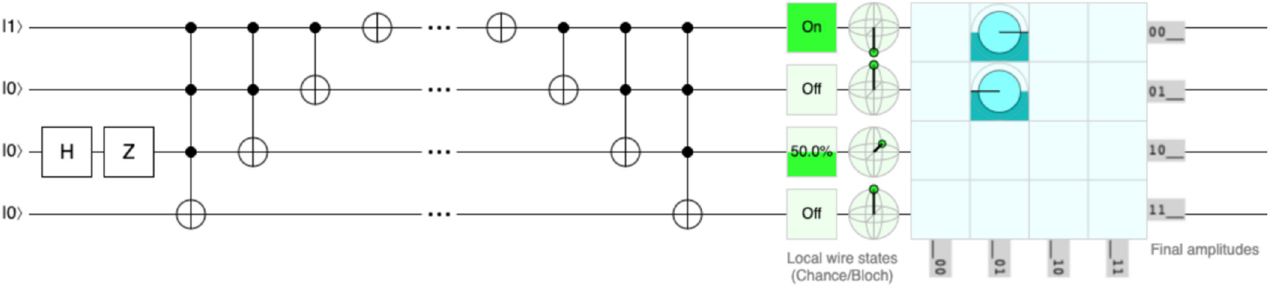
Figure 2. A quantum circuit including four qubits and implementing the increment (first part) and decrement (second part) of an integer (image obtained using the https://algassert.com tool, accessed on 23 June 2021).